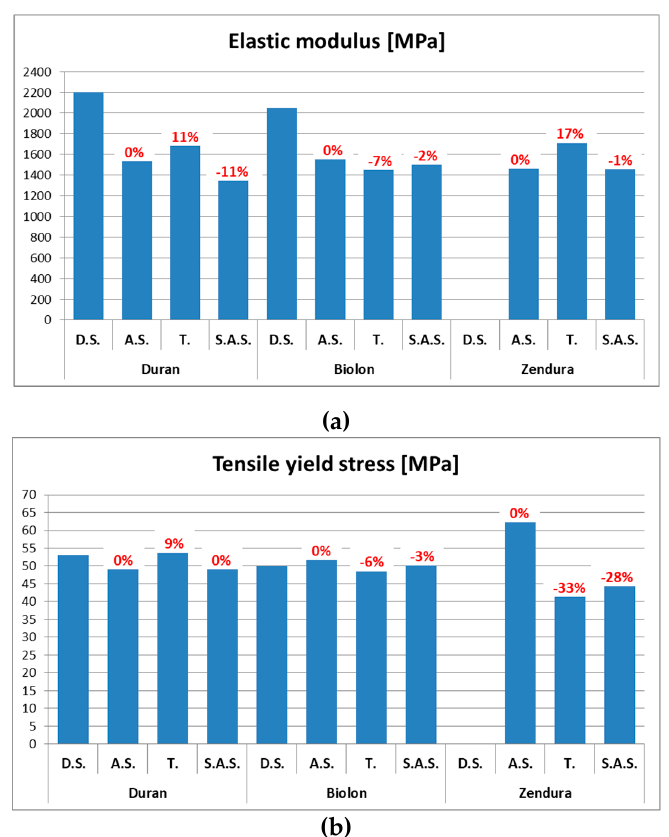
Figure 4. Mean value of elastic modulus ( a ) and tensile yield stress ( b ) for each material and test condition (D.S., A.S., T., S.A.S.). The percentage of increment or decrement after T. and S.A.S. with respect to A.S. is shown.